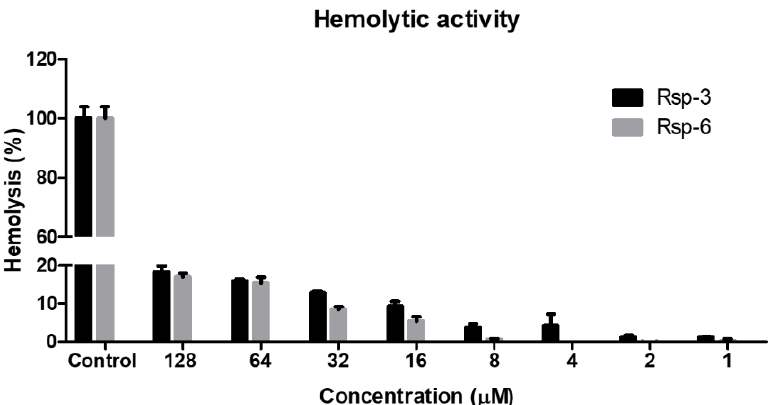
Figure 8. Hemolytic activity of Raniseptins-3 and -6 against human erythrocytes. Data points show mean ± SD.